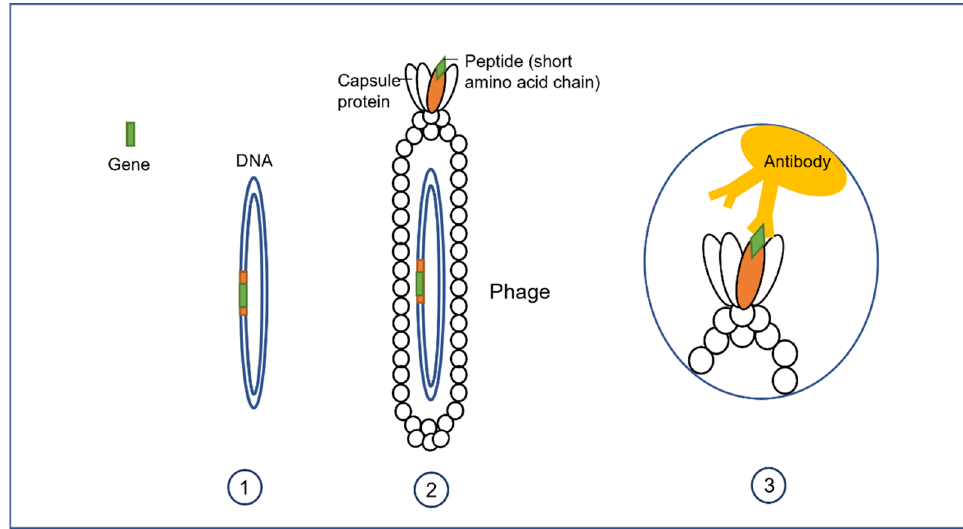
Figure 2. Summary of the technique designed by George Smith, during his time at the University of Missouri, which laid the foundations for the phage display technology. 1: A foreign gene is introduced into the coding region of a viral capsid protein, and expressed as a fusion with the phage polypeptide. The viral DNA is then inserted into bacteria, allowing the phage to multiply. 2: The peptide encoded by the heterologous gene, fused to a capsid protein, is displayed on the surface of the bacteriophage. 3: The final refinement devised by Smith was the use of an antibody, that recognized the foreign peptide, to identify the phage particles displaying the fusion protein. Currently, phage display constitutes a very powerful molecular biology technique, extensively used in many areas of research. This method plays a pivotal role in the identification of novel target ligands, a procedure that requires the construction of specific peptide libraries, that are expressed on the surface of the bacteriophage fused to a viral protein.